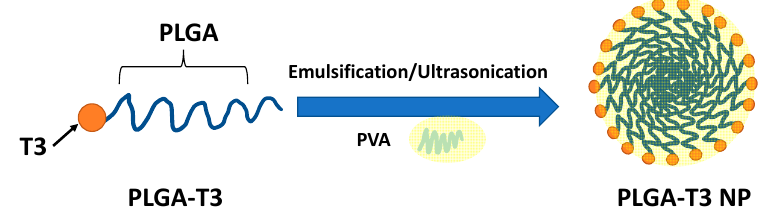
Figure 1. Schematic representation of PLGA-T3 NP preparation.